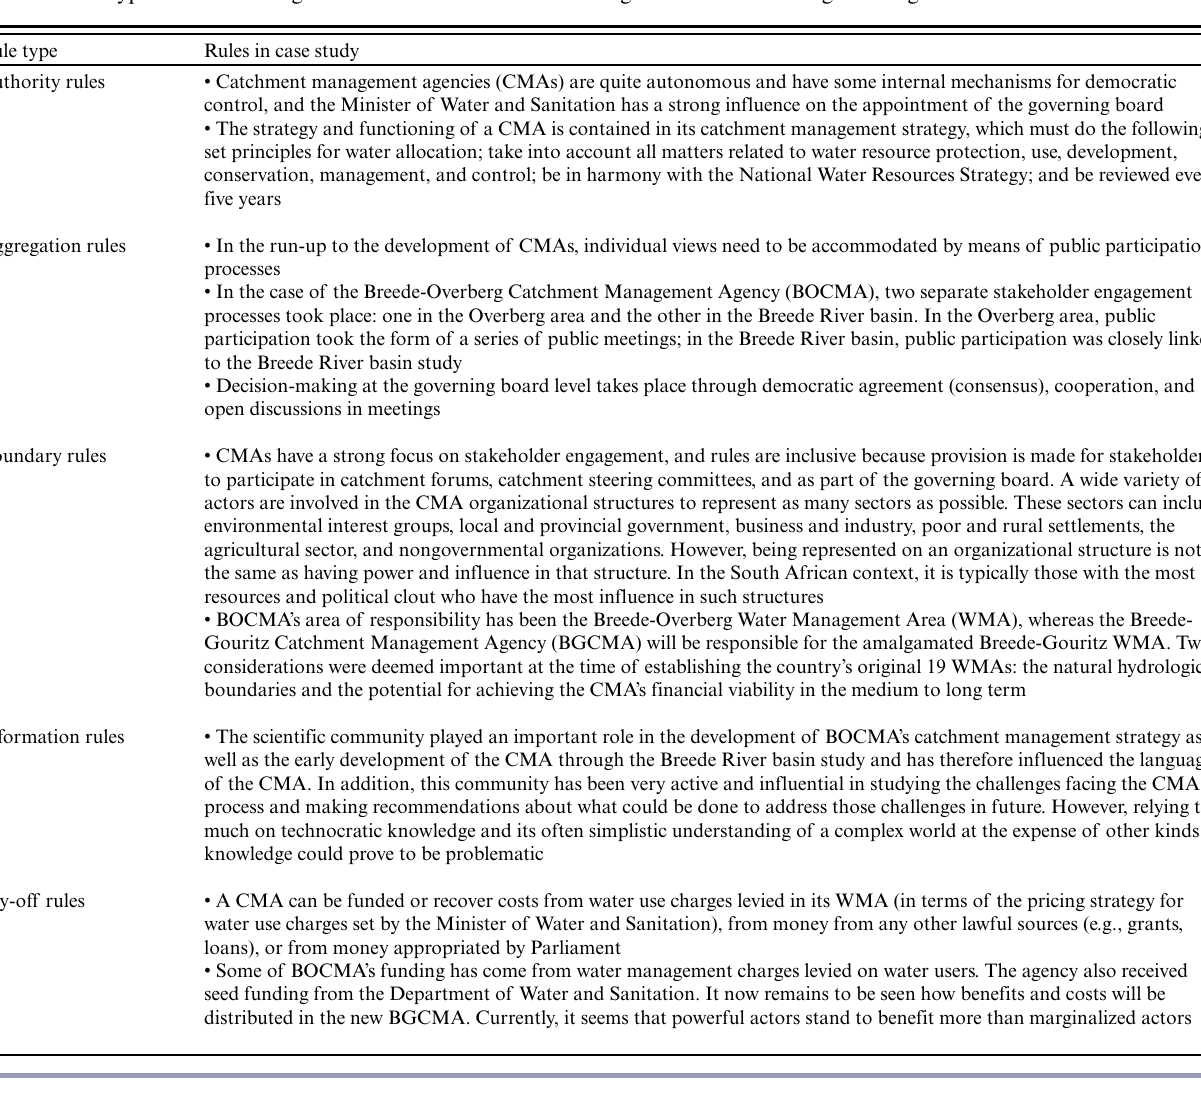
Table 1. Rule types evident during the establishment and functioning of catchment management